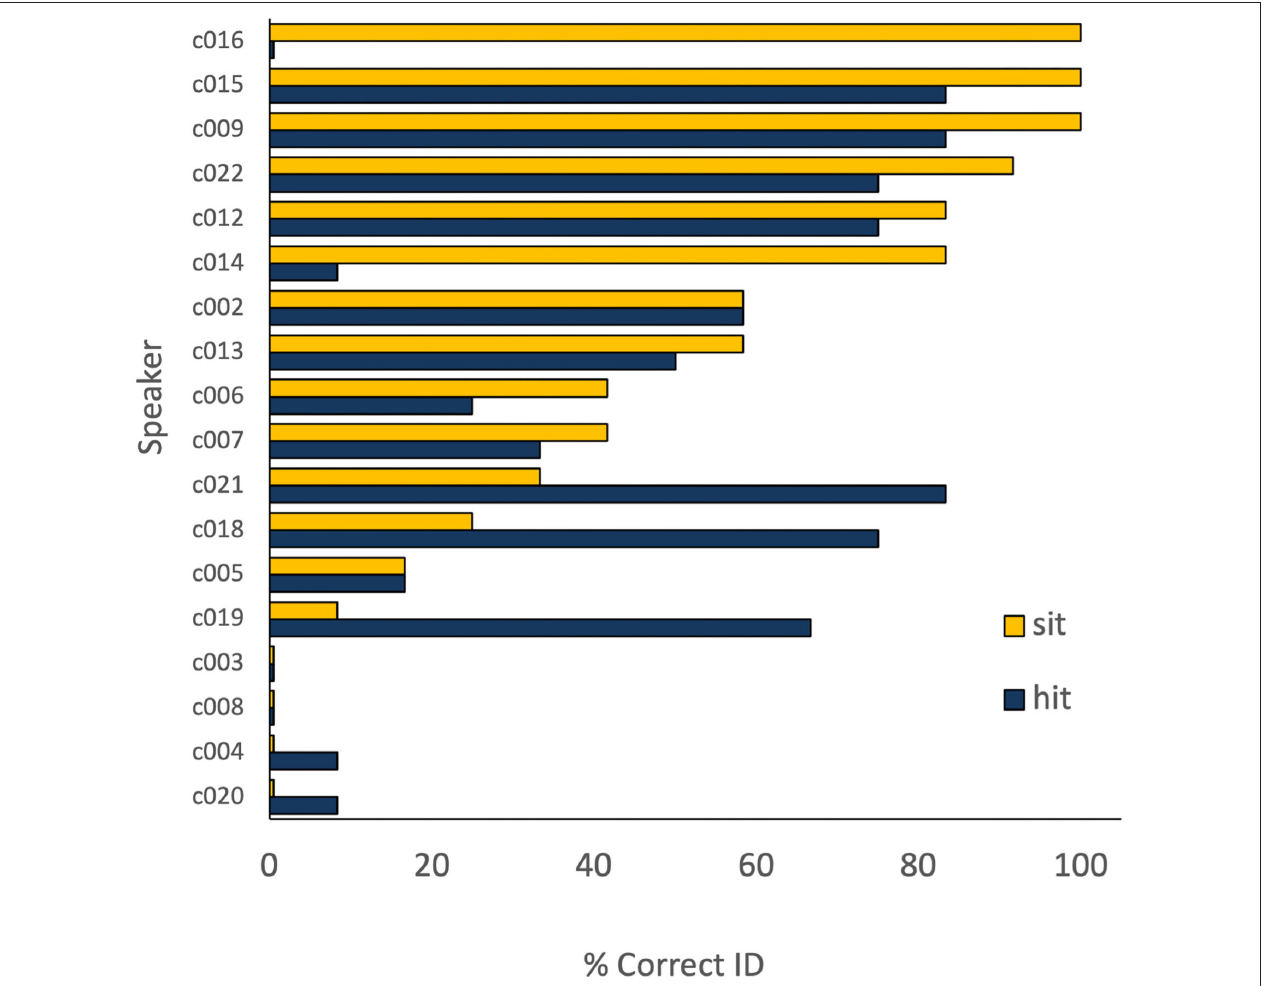
FIGURE 2 | Individual speaker performance (% intelligibility) on hit and sit .